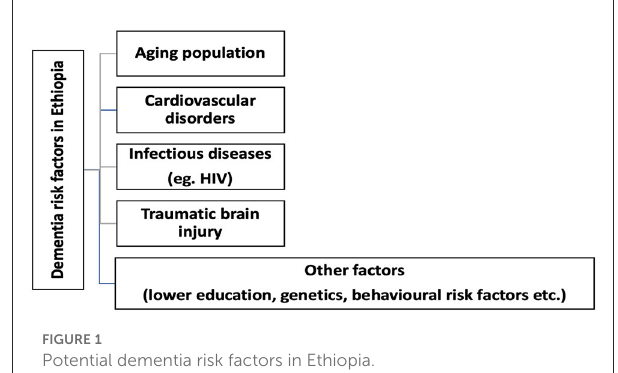
FIGURE1 Potential dementia risk factors in